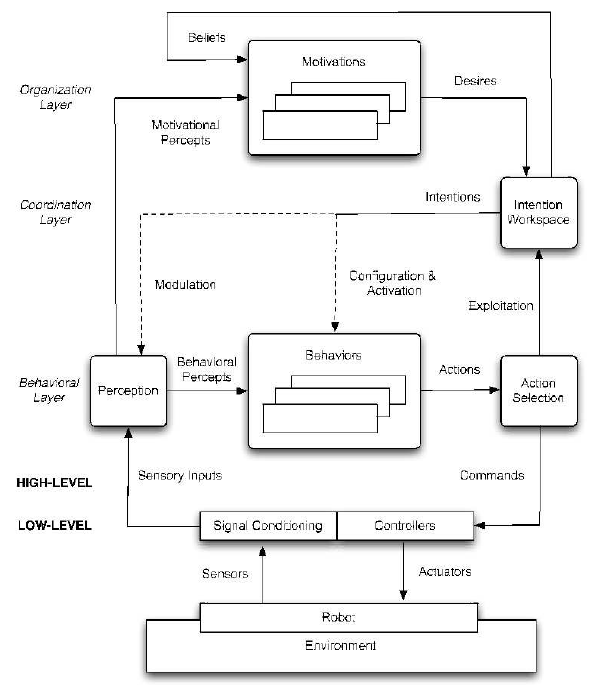
Figure 4. Hybrid Behavior-Based